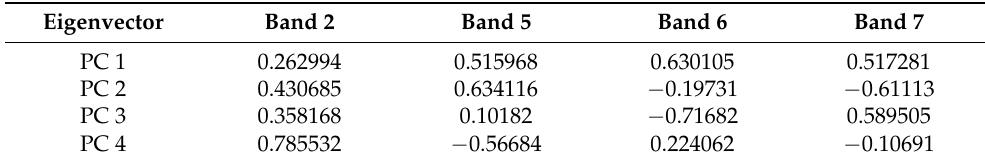
Table 9. Eigenvector loading for PC bands 2, 5, 6, and